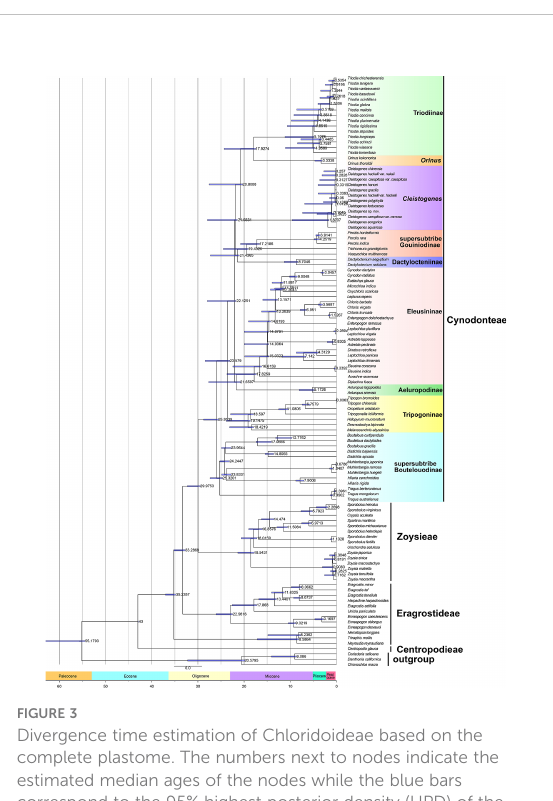
FIGURE 3 Divergence time estimation of Chloridoideae based on the complete plastome. The numbers next to nodes indicate the estimated median ages of the nodes while the blue bars correspond to the 95% highest posterior density (HPD) of the estimated